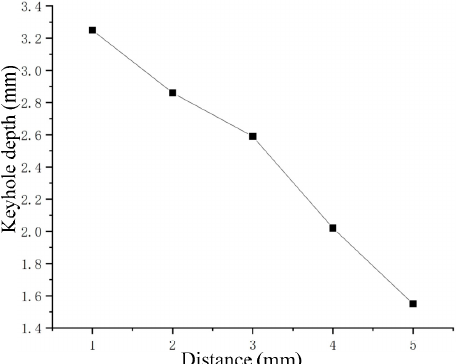
Figure 11. Keyhole in Ga–In–Sn alloy: ( a ) Stationary keyhole; ( b ) Dynamic keyhole.